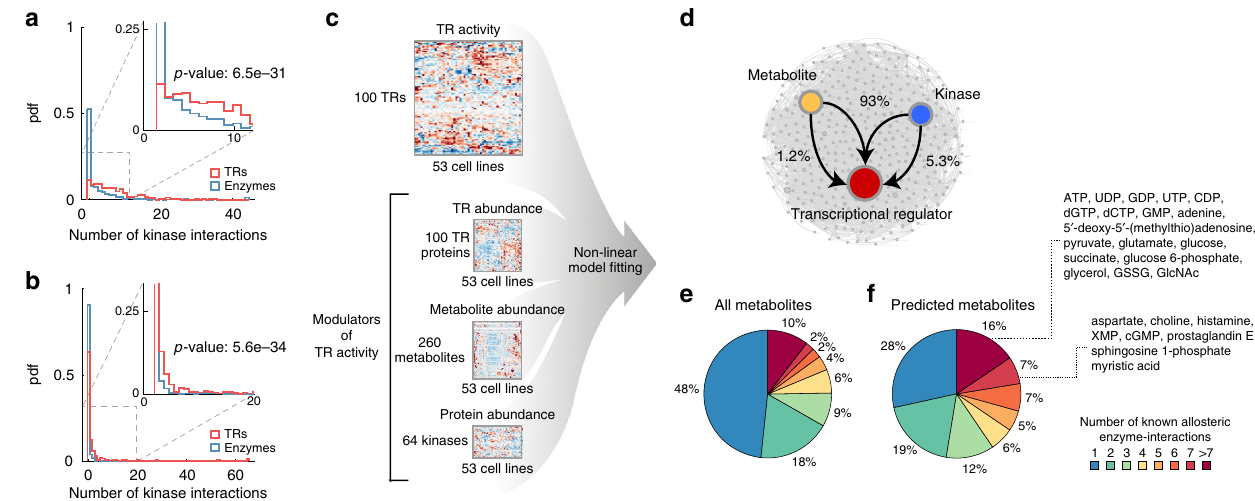
Fig. 5 Modeling TR activity using an ensemble of non-linear models. a , b Probability density function (pdf) of the number of kinases reported to interact with TRs (red) and metabolic enzymes (blue) in yeast 55 ( a ) and human 56 ( b ). P -values report on the signi fi cance of the difference between TRs and enzyme pdfs (Kolmogorov – Smirnov test). c Schematic overview of the computational framework. Three layers of biological information are integrated using a model-based fi tting approach: protein abundance of 100 TRs and 64 kinases, respective TR activities derived from transcriptome data using NCA and relative levels of 260 metabolites across cell lines (see Methods section). d Predicted network of modulatory interactions between TRs, metabolites and kinases. Most interactions involve the combined action of a metabolite and a kinase (93% of interactions, Supplementary Data 5). e , f The pie chart represents the distribution of metabolites allosterically regulating one or more enzymatic reactions. All metabolites (1633) with at least one known allosteric interaction in human 26 are reported in e , while only metabolites predicted to modulate the activity of at least one TR are shown in panel f . Metabolites that regulate more than seven enzymatic reaction are lumped